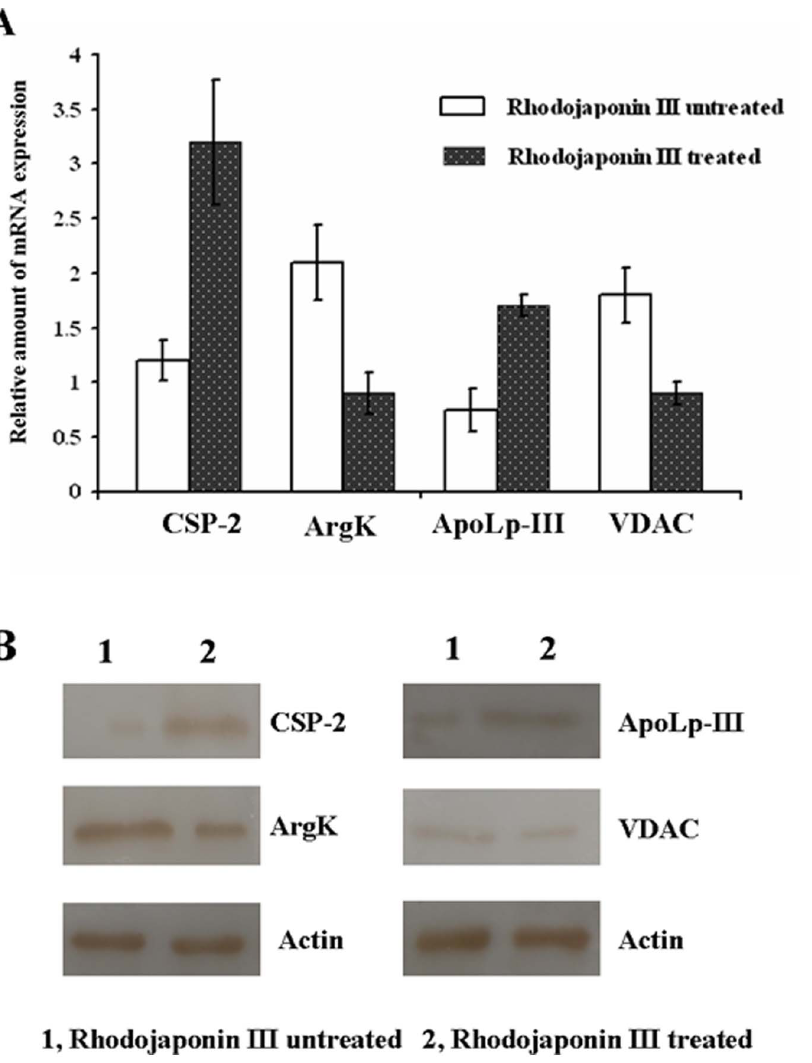
Figure 3. Validation of differentially expressed proteins in control and exposed to rhodojaponin III moths (PxCSP-2, PxArgK, PxApoLp-III and PxVDAC genes were selected randomly). A, qRT-PCR, B, Western blot. The mRNA level was normalized relative to the actin transcript. Each point represents the mean value 6 S.E.M of three independent experiments with three individuals in each replicate.